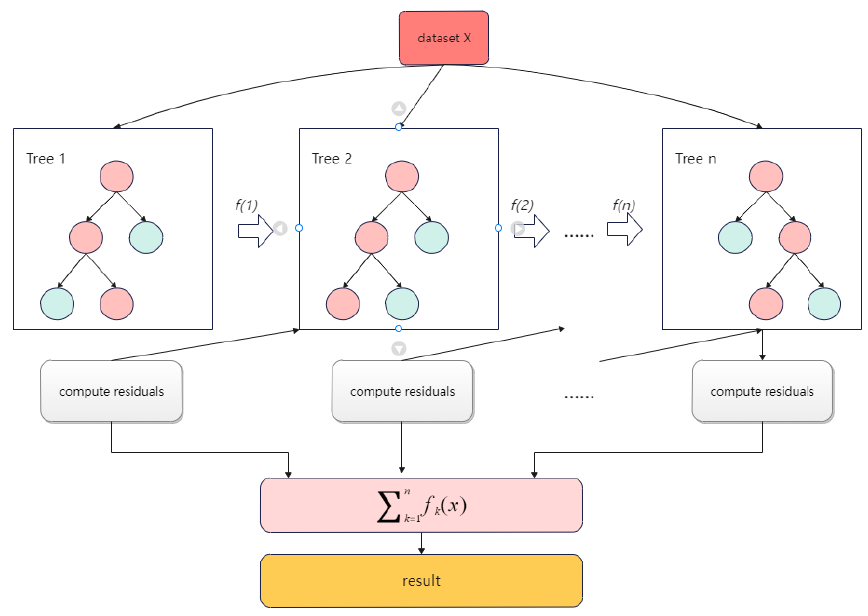
Figure 2. Diagram of XGBoost prediction flow.